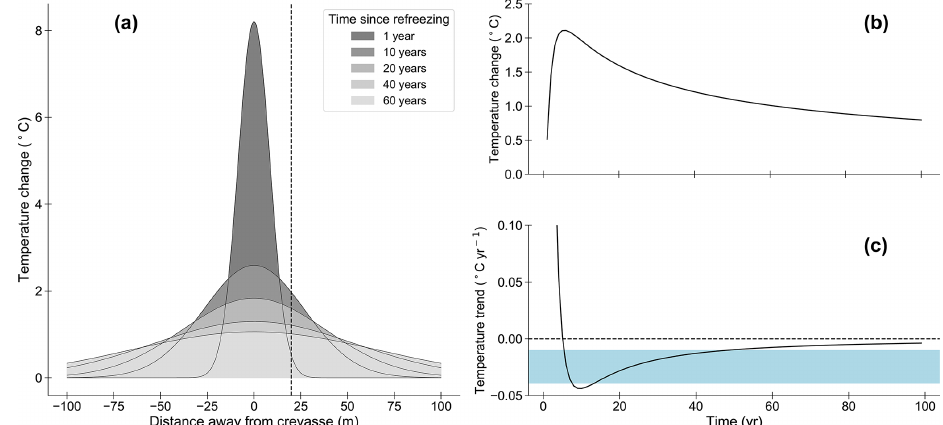
Figure 6. (a) Modeled changes in temperature after a crevasse 1m wide refreezes. Darker colors show earlier times. Dashed line indicates a distance 20m from the crevasse, for which temperatures and temporal rates of temperature change are shown in (b) and (c) . (b) Changes in temperature over time 20m away from the basal crevasse. (c) Corresponding rates of temperature change for (b) . The blue shaded region shows the range of averaged rates of cooling in the lowest 100m of the boreholes.